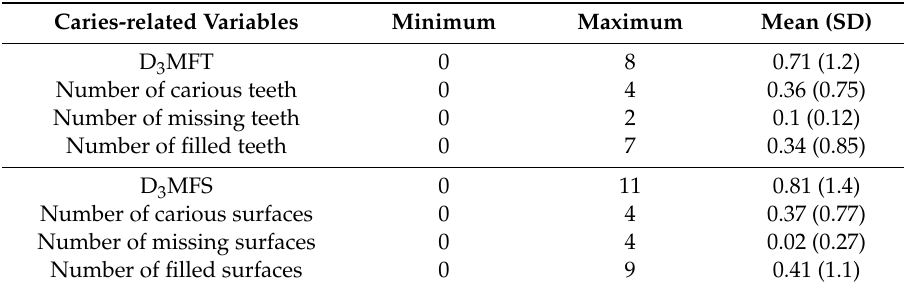
Table 2. Caries experience of the